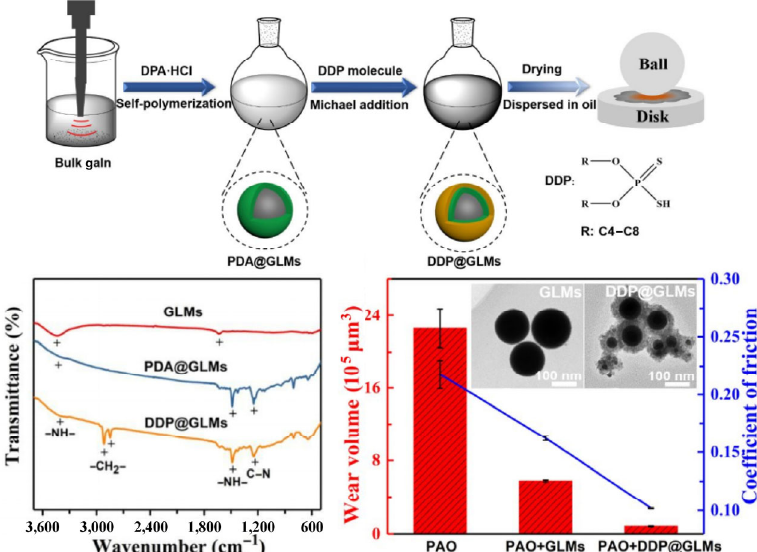
Fig. 5 Preparation process, FT-IR spectra, and results of tribological tests of DDP@GLMs. Reproduced with permission from Ref. [46], © American Chemical Society